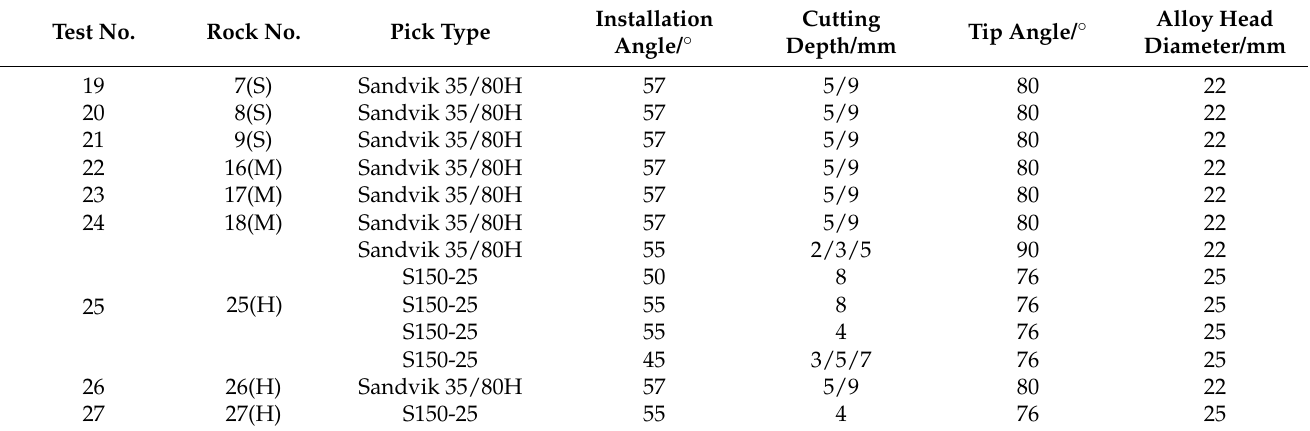
Table 6. The added cutting conditions for the third prediction performance analysis.